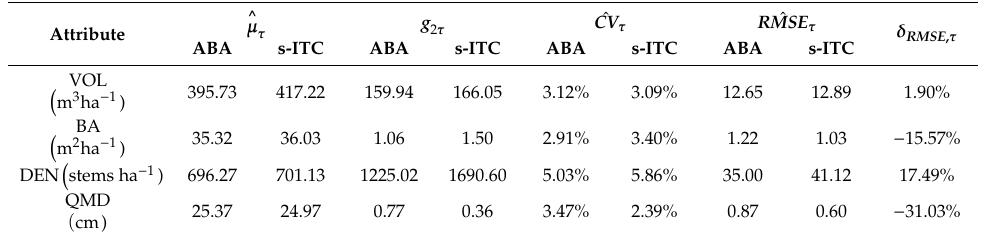
Table 5. Predictions of forest attributes and error components at the scale of the study region. Note that, for all models, g 1 τ and g 3 τ were < 0.01 and are not included in this